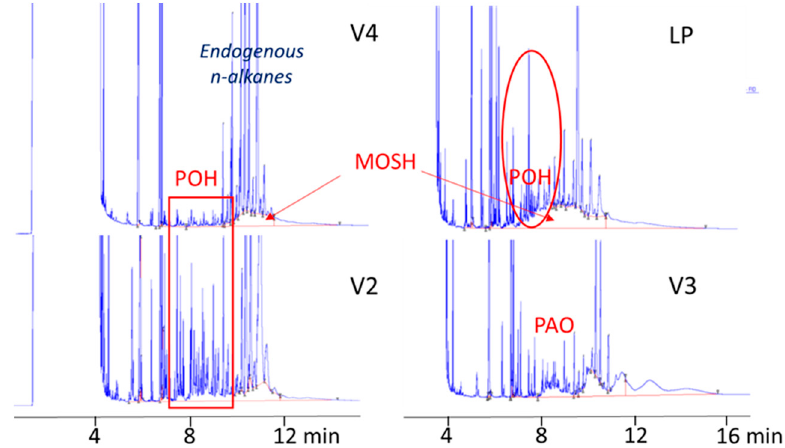
Figure 4. HPLC-GC traces of vegetable soup samples before microwave heating.